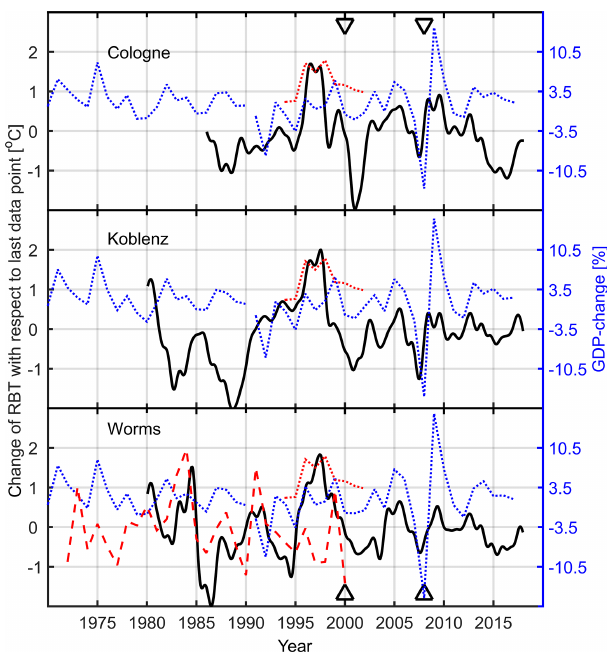
Figure 7. The change in RBT (black solid line) at three monitoring stations (Cologne, Koblenz and Worms). The blue dashed line is the GDP change in the adjacent federal states. To explain trends during two time periods, the red dashed line, which is the turnover of BASF, and the red dotted line, which is the production rate of the oil refineries, were added. The triangles mark the years 2000 (burst of the dot-com bubble) and 2008 (mortgage